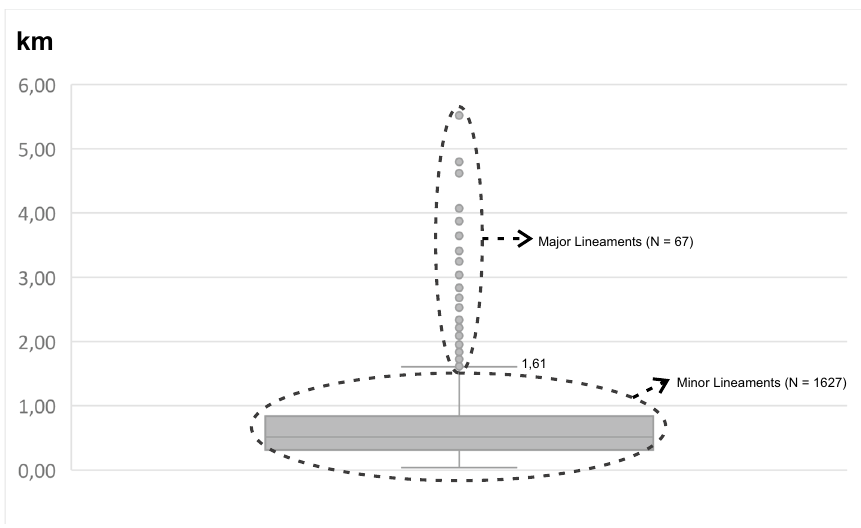
Fig. 8 Clusterization of lineament length in